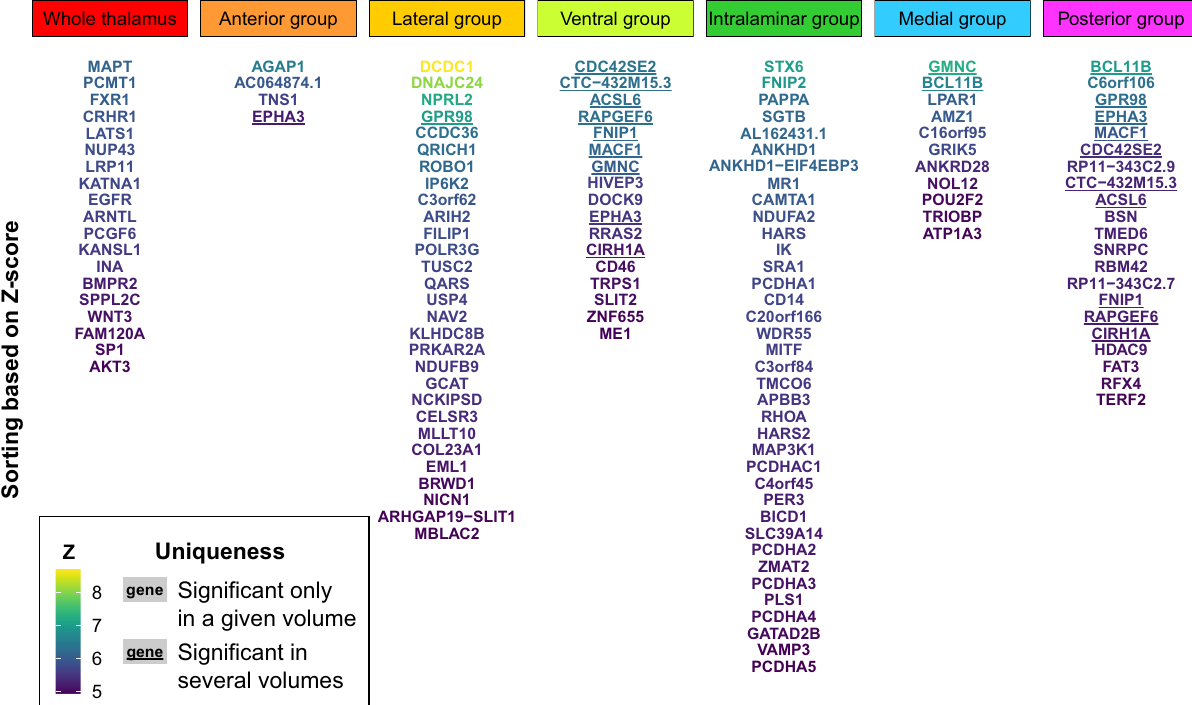
Fig. 2 GWGAS identi fi es 127 unique genes associated with thalamic volumes. Nineteen genes were associated with whole thalamus; 4, 29, and 17 genes were associated with volumes of the anterior, lateral, and ventral nuclei; and 37, 11, and 21 genes were associated with intralaminar, medial, and posterior nuclei volumes, respectively. Lighter font color and higher position for gene names indicate greater Z -score. Underlined gene names designate genes that were signi fi cantly associated with more than one volume, whereas gene names not underlined indicate genes associated with only one volume. Additional results of the GWGAS are presented in Supplementary Data 12. GWGAS, genome-wide gene-based association